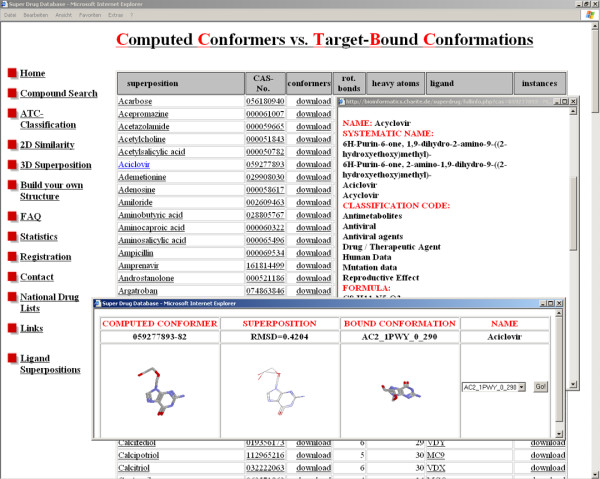
Website. Screenshot of the website providing supporting information [1].